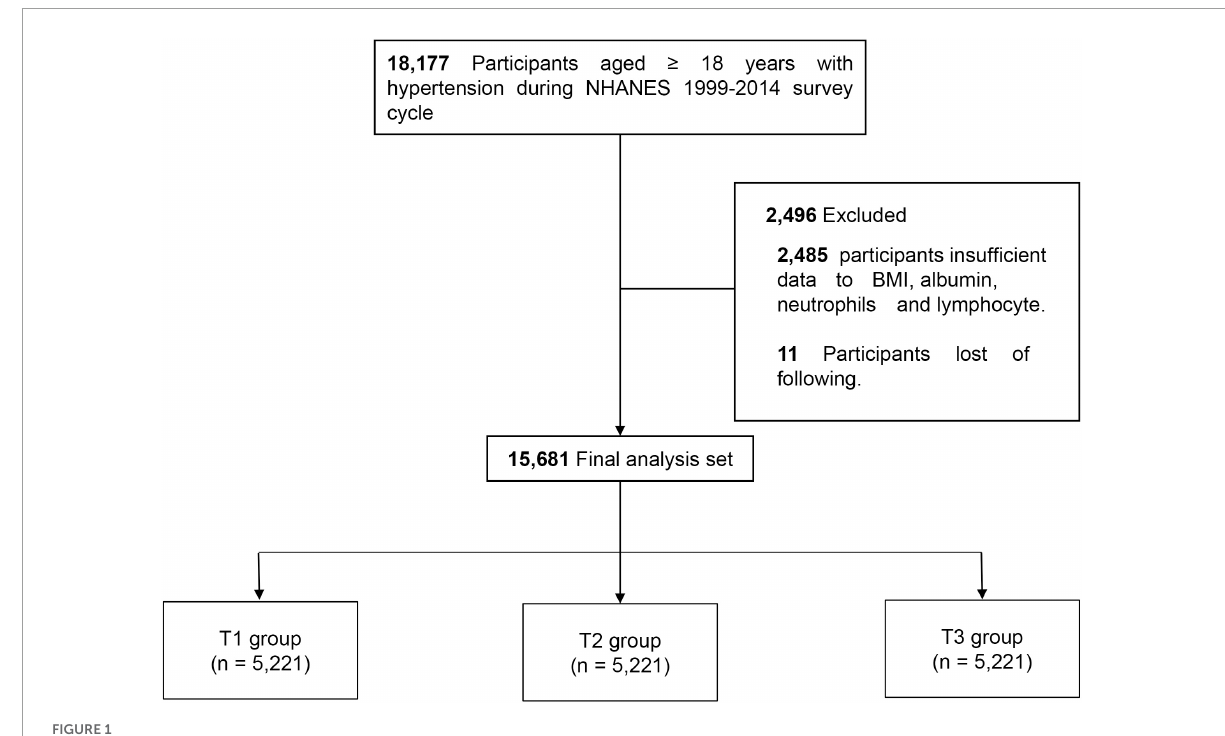
FIGURE1 Flowchart of study design.